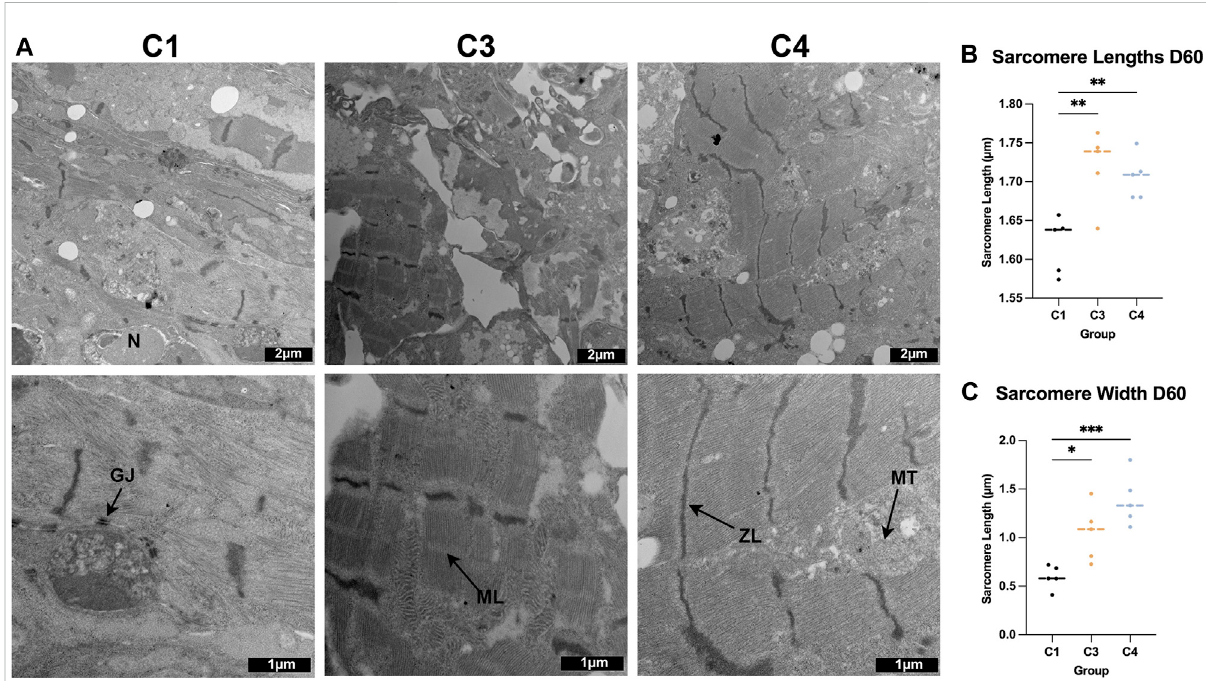
FIGURE 6 TEM assessments of the ultrastructure of C1, C3, and C4 spheroids. (A) Whole C1, C3, and C4 spheroids on day 60 were sectioned and imaged via TEM (bar = 2 μ M for the top row, and bar = 1 μ M for the bottom row); ZL: Z-line, ML: M-line, MT: mitochondria, GJ: gap junction, N: nucleus. (B) SarcomerelengthswerecalculatedbymeasuringthedistancebetweenadjacentZ-lines. (C) Sarcomerewidthsweremeasuredasthelengthofeach uninterrupted Z-line. (* p < 0.05, ** p < 0.01, *** p < 0.001; n > 5 spheroids per